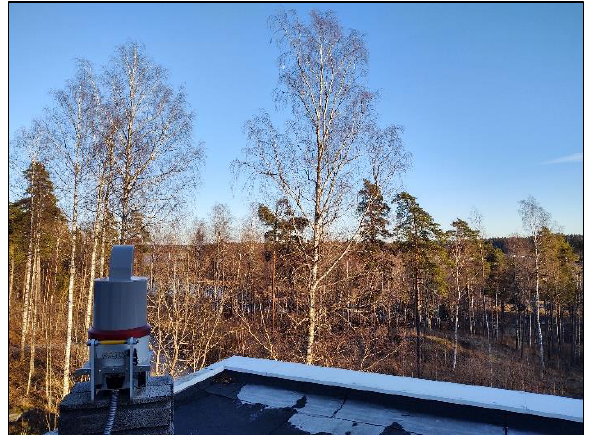
Figure 1. Test area view after data acquisition campaign in February 2020 with RIEGL VZ-2000i laser scanner facing the test